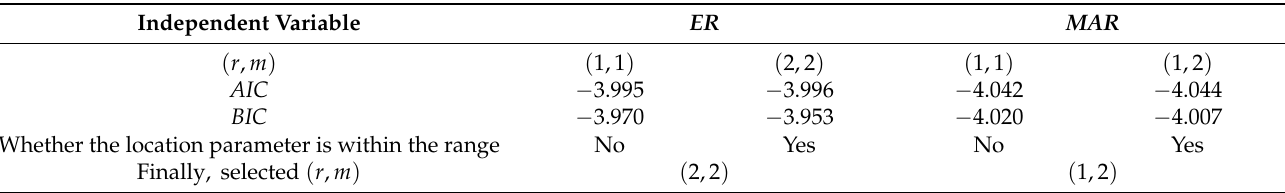
Table 4. Model parameters